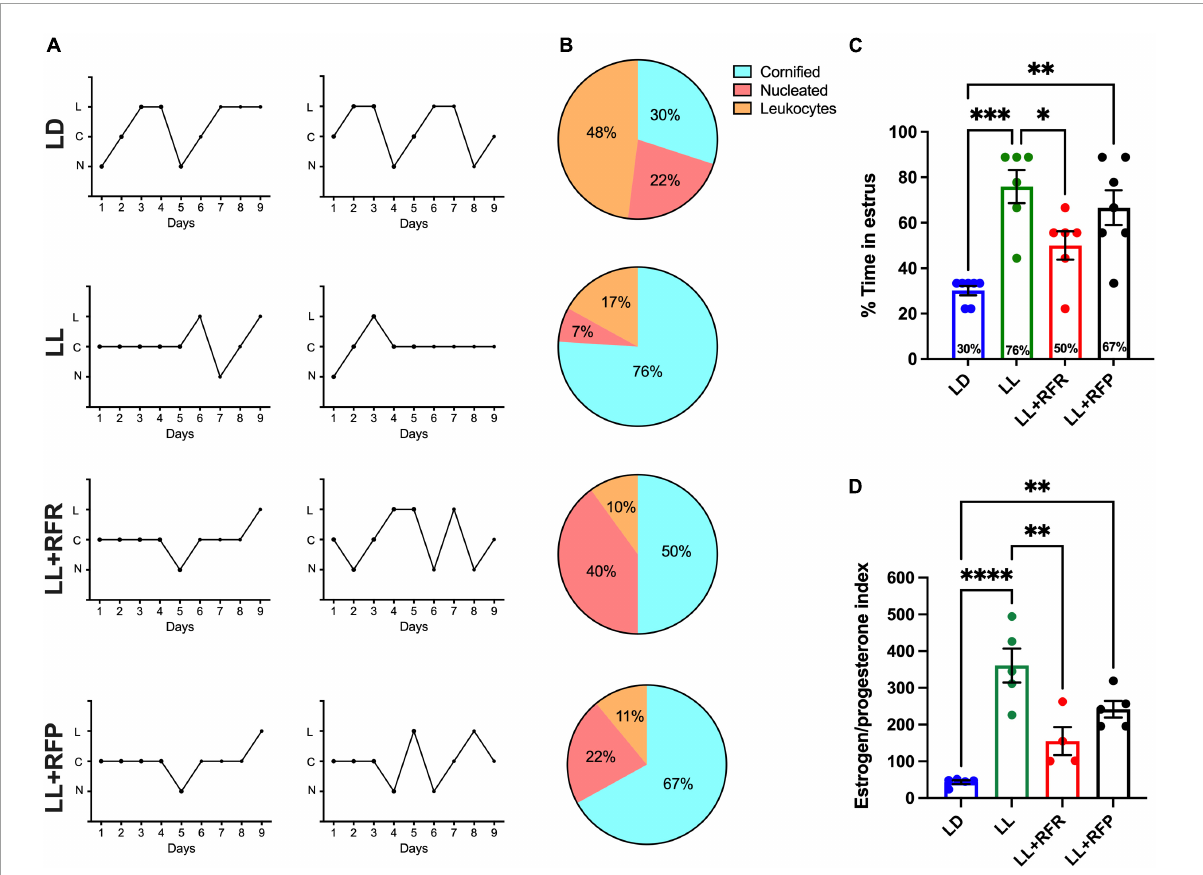
FIGURE3 Estrous cycles obtained by 9-day vaginal smears. (A) Two representative cycles obtained with the cytology in the vaginal smears of rats exposed to a regular light–dark cycle (LD) from rats exposed to constant light (LL, second top) and rats exposed for 3 weeks to LL followed by 3 weeks of 12-h restricted feeding as a rescue strategy (LL + RFR) and rats exposed to LL simultaneously to RF for 6 weeks as a preventive strategy (LL + RFP). (B) Percentage of rats showing predominance for a given cellular type at each day of the estrous stage according to vaginal cytology. (C) Proportion of days in which rats displayed estrus. (D) Estrogen/progesterone (E 2 /P) ratio. Data are expressed as the mean ± SEM; n = 4–5/group. Asterisks indicate * P < 0.05, ** P < 0.01, *** P < 0.001; **** P < 0.0001. C, cornified cells; L, leukocytes; N, nucleated cells.